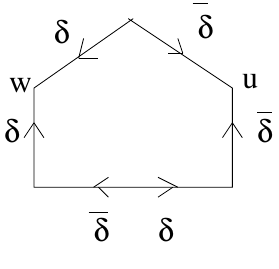
Figure 11 . Skeleton graph for (cid:8) 12 ;A